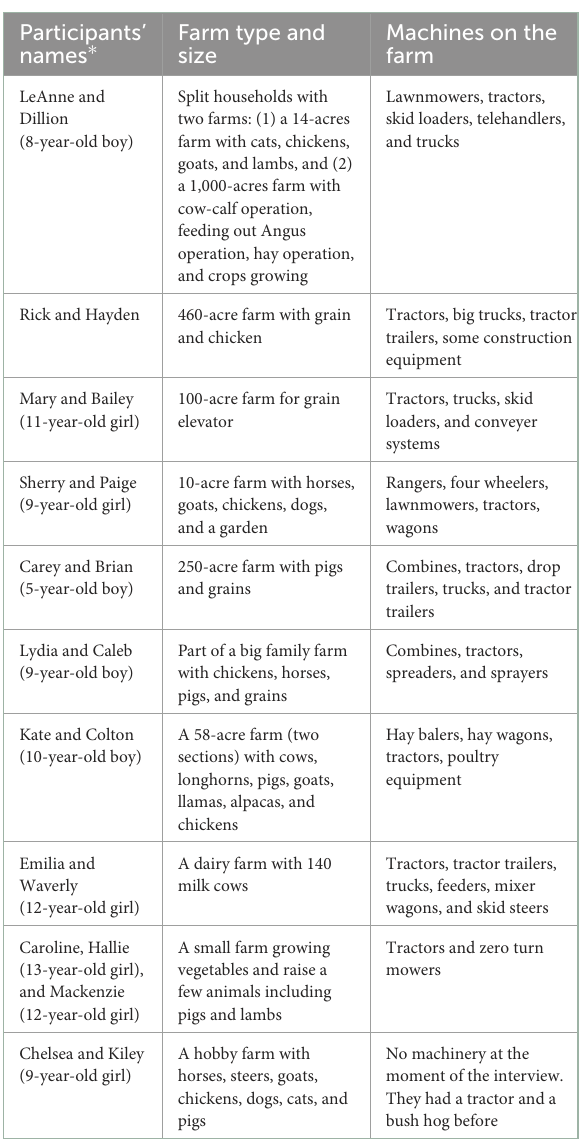
TABLE 1 Demographic and farm information of